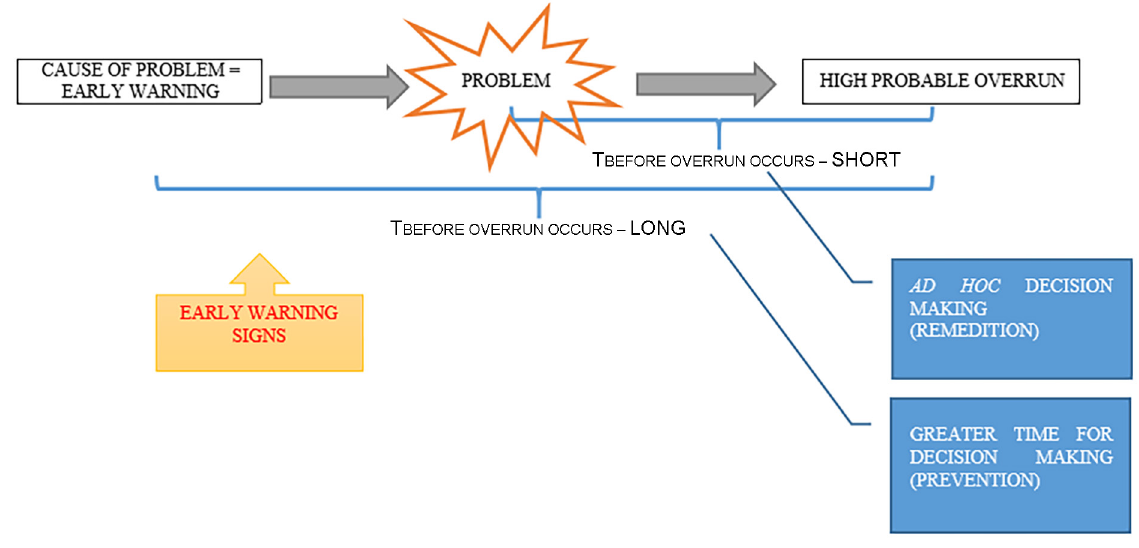
Figure 1. Ad hoc decision-making vs. decision-making based on